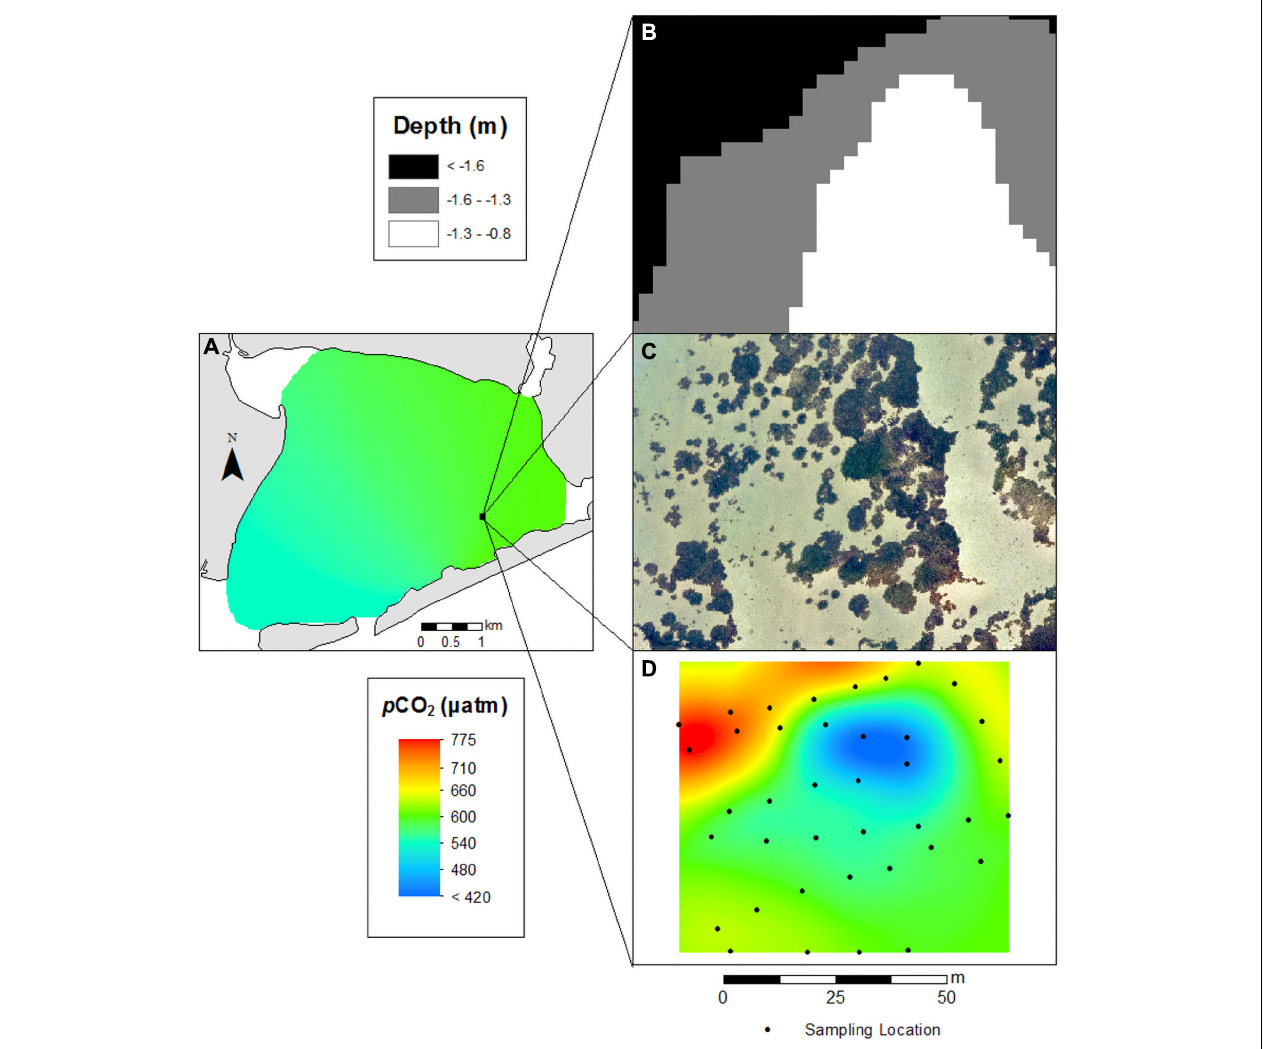
FIGURE 9 | (A) High resolution survey of p CO 2 in eastern Shinnecock Bay. (B) High resolution depth measurements (3 m horizontal resolution), (C) high resolution drone imagery, and (D) p CO 2 measurements sampled at 10 cm above the sediment-water interface encompassing a 6300 m 2 region surrounding seagrass site